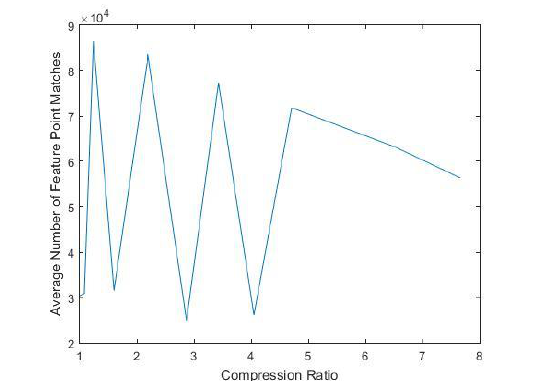
Figure 12. Average number of feature point matches of the original and compressed image sets The average ratio of inlier matches of the original and compressed image sets is shown in Figure 13. It can be seen that the average ratio of inlier matches is not influenced by the compression ratio when the images are lossless and lowly compressed. The average ratio of inlier matches of the original image sets is almost the same as that of the lossless compressed image sets. The average ratio of inlier matches drops dramatically to 18.45% when the compression ratio reaches 7.66. A larger proportion of the extracted feature points are inconsistent with the final fundamental matrix when matching the highly compressed images.